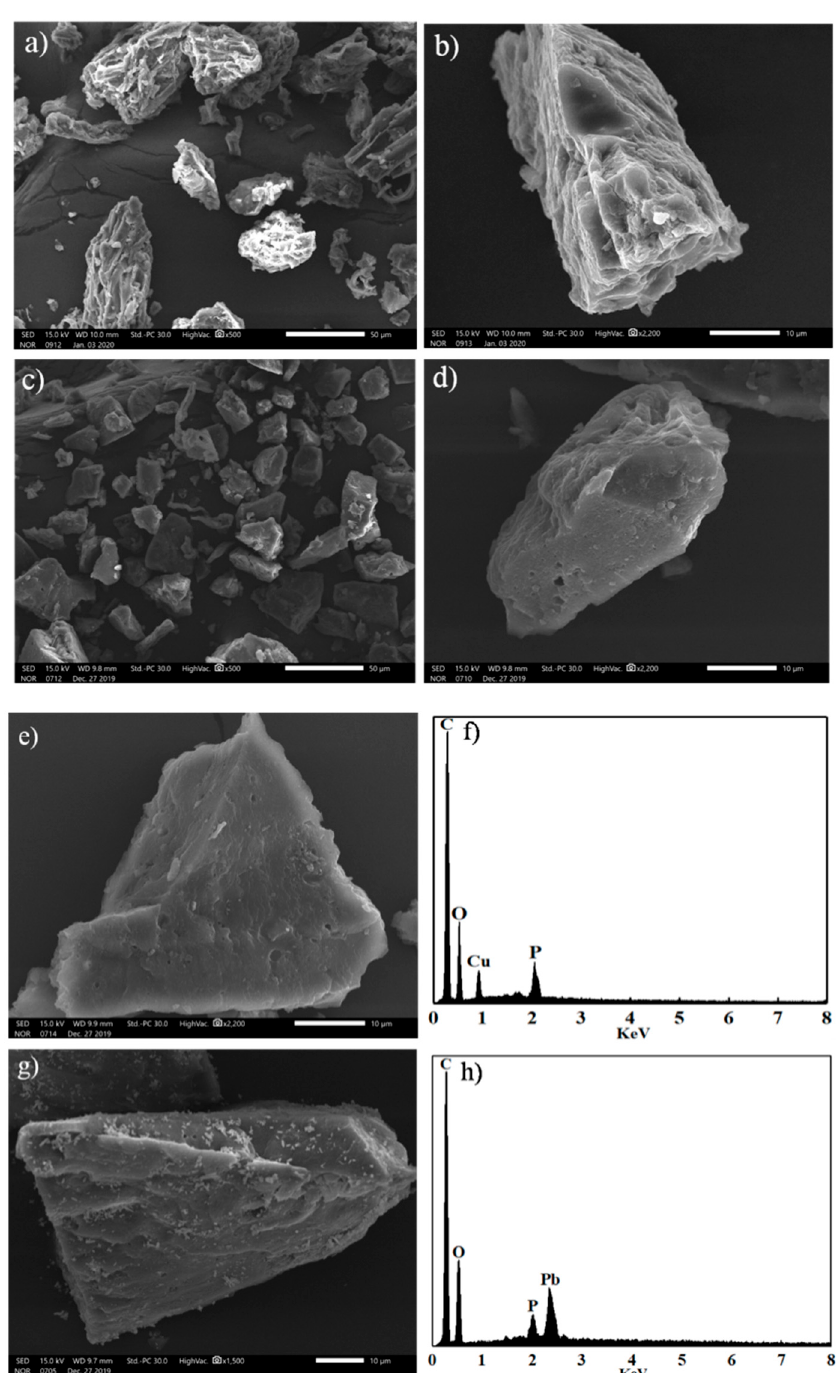
Figure 2. Scanning electron microscopy ( SEM) images of CL ( a , b ), CLB ( c , d ) with different magnification, and CLB after 0.3 mM Cu(II) ( e ) and 0.3 mM Pb(II) ( g ) adsorption, respectively, with corresponding energy dispersive X-ray spectroscopy (EDS) (Cu(II) ( f ), Pb(II) ( h )).